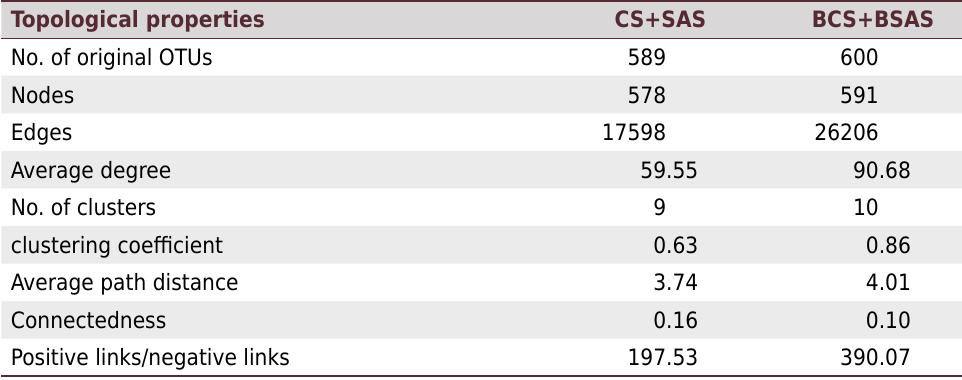
Table 4. Topological features of bacteria co-occurrence network in soils under biaochar application Topological